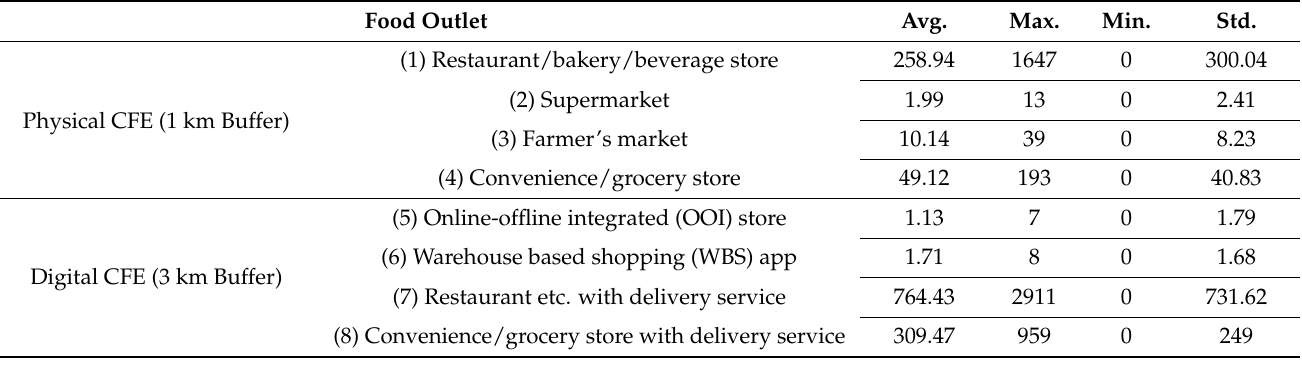
Table 3. Number of different food outlets in sampled communities.